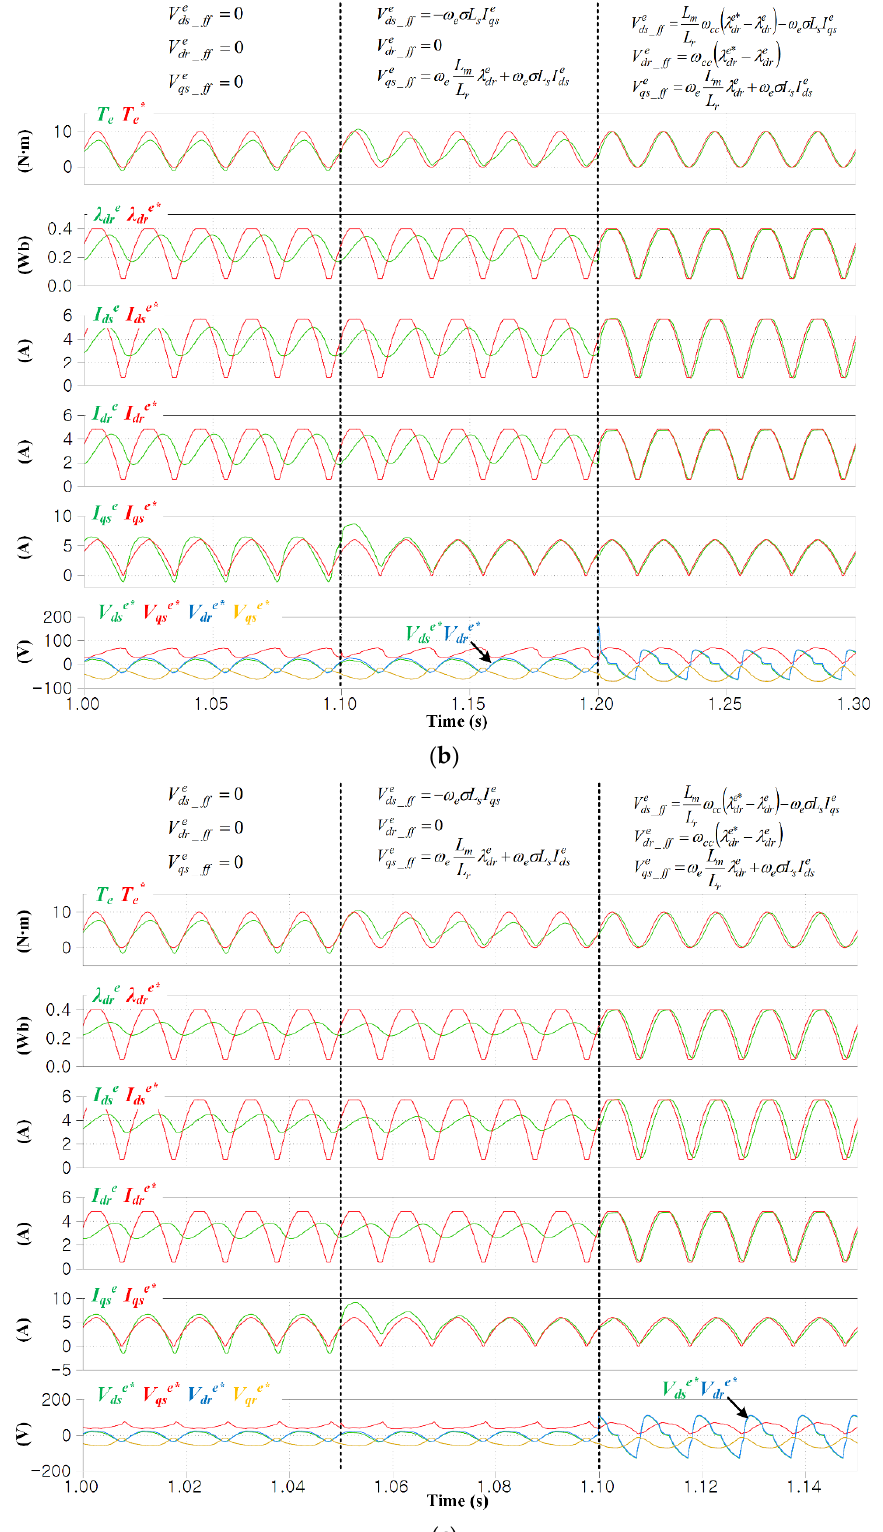
Figure 7. Simulation results for the current, rotor flux, and torque controls according to sinusoidal torque reference at the rated speed (1055 r/min): ( a ) 10 Hz; ( b ) 50 Hz; ( c ) 100 Hz.